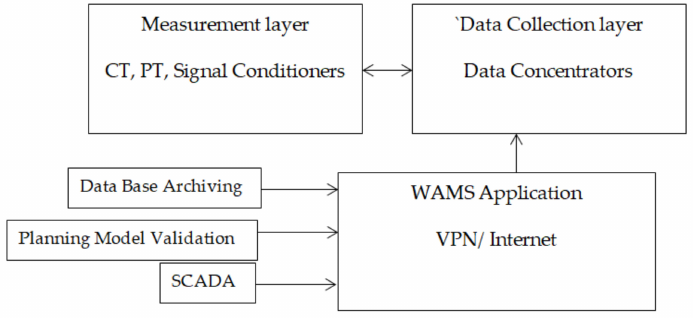
Figure 8. Basic architecture of ST.